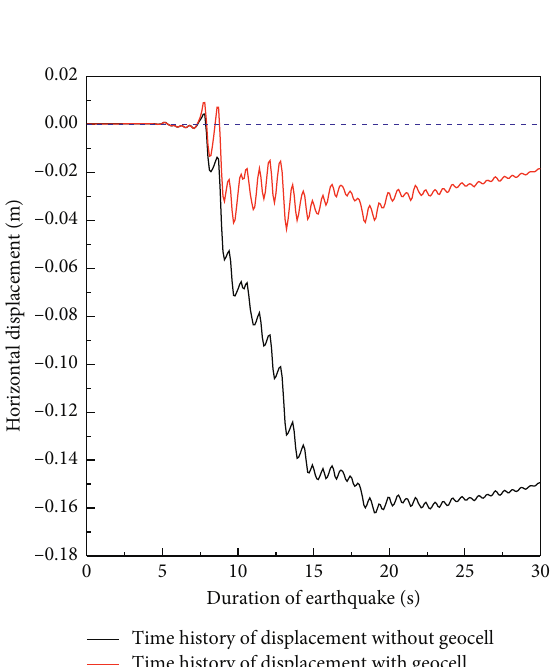
Figure 5: Displacement-time-history of monitoring point